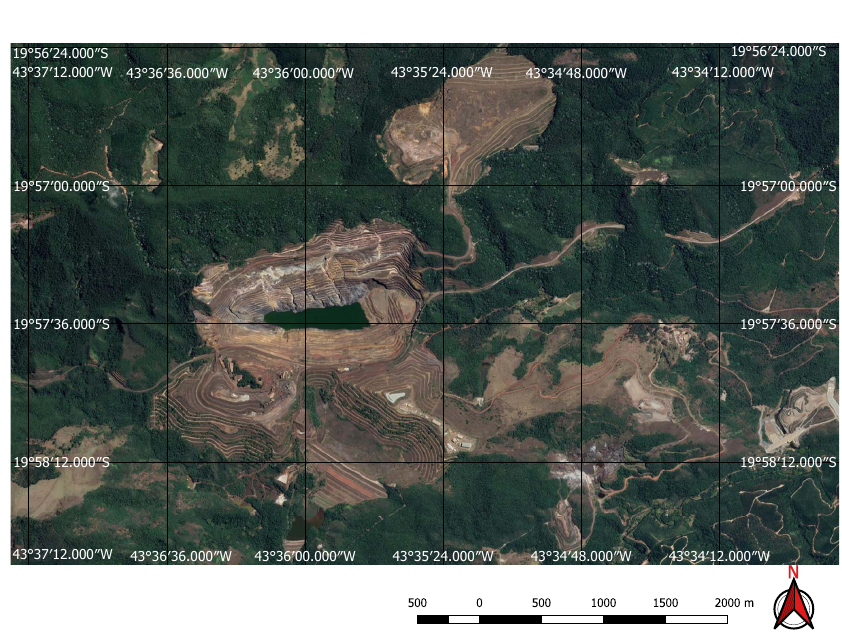
Figure 5. Example of a gold mine.